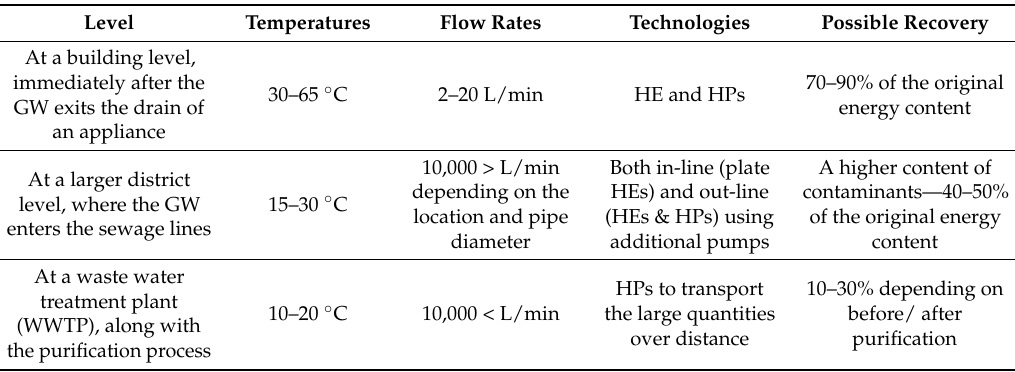
Table 2. Different levels of waste water heat harnessing.